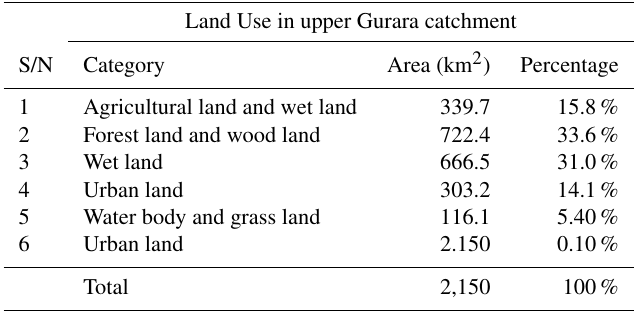
Table 1. Land use and land cover around GRC (Source: modified from WEAP model